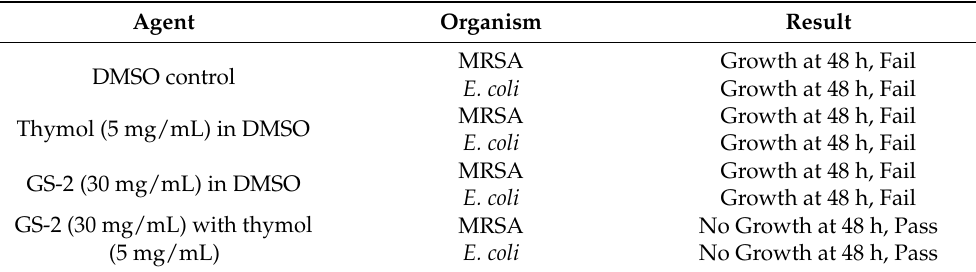
Table 5. Testing of GS-2 (30 mg/mL) with thymol (5 mg/mL) using TGA Option C disinfectant testing methods (8 min exposure) in 5 technical replicates. A pass result required at least 2 of the 5 tubes to be clear (i.e., no growth) after 48 h.